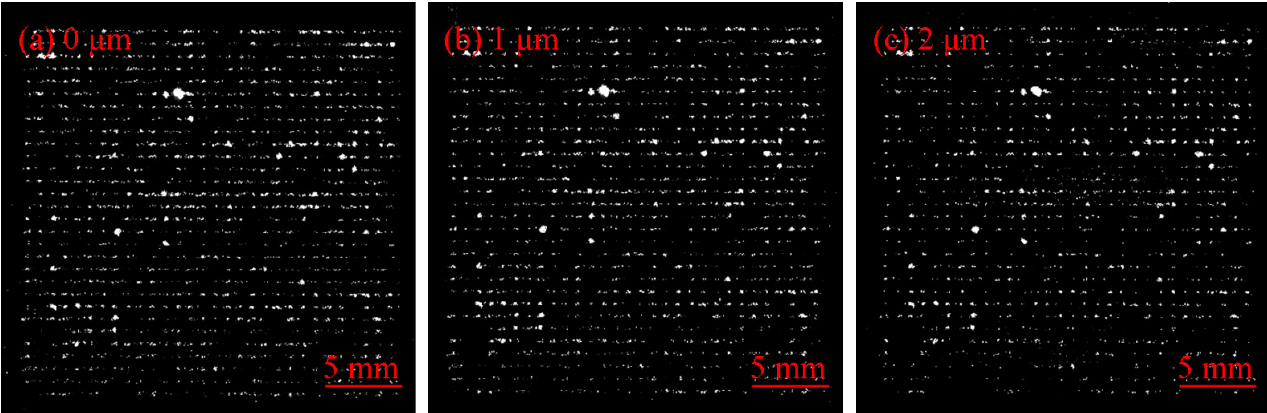
Table 1. Parameters of the MR process.